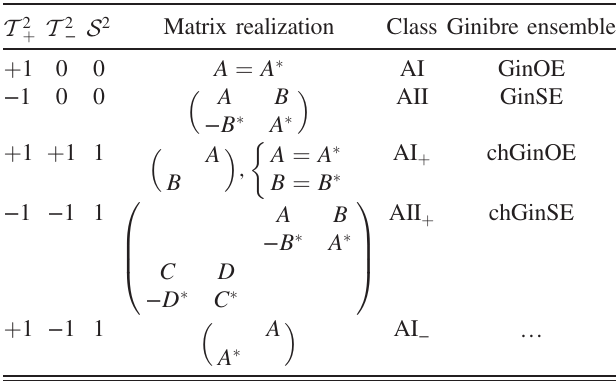
TABLE VII. Non-Hermitian symmetry classes with reality conditions but no pseudo-Hermiticity, four of which are realized in the complex-fermion nHSYK model (i.e., all except class AI − ). For each class, we list its antiunitary and chiral symmetries, an explicit matrix realization [92], its name under the Kawabata- Shiozaki-Ueda-Sato classification [66], and its name as a Ginibre ensemble (class AI − has no conventional Ginibre name). In the matrix realizations, A , B , C , and D are arbitrary non-Hermitian matrices unless specified otherwise, and empty entries corre- spond to